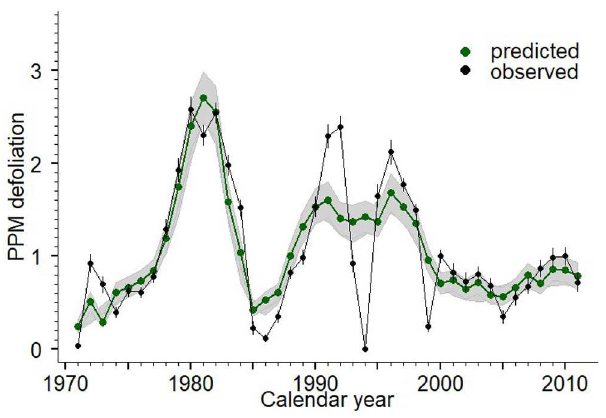
FIGURE 2 | Observed and predicted values of pine processionary moth (PPM) defoliation (0–5) at the regional scale (data from Mora de Rubielos study area, Teruel, Spain). The black line and dots represent the observed values of PPM defoliation at regional scale (mean across the 92 sites) and the vertical bars indicate the standard errors. The green circles and line indicate the predicted PPM defoliation according to Generalized Additive Mixed Models including the covariates presented in Table 2